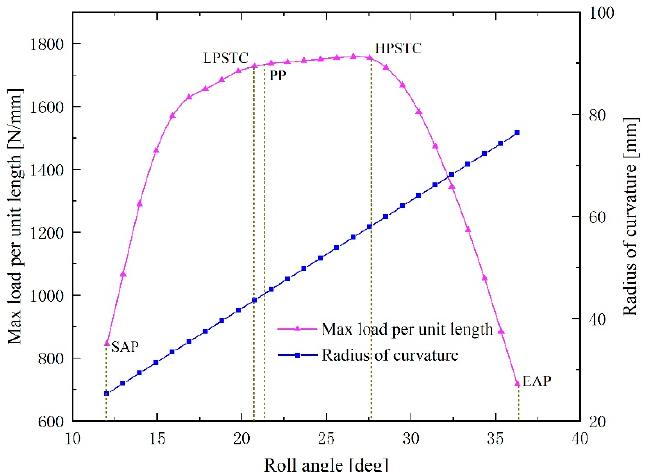
Figure 9. The distribution of unit length load and equivalent radius of curvature.